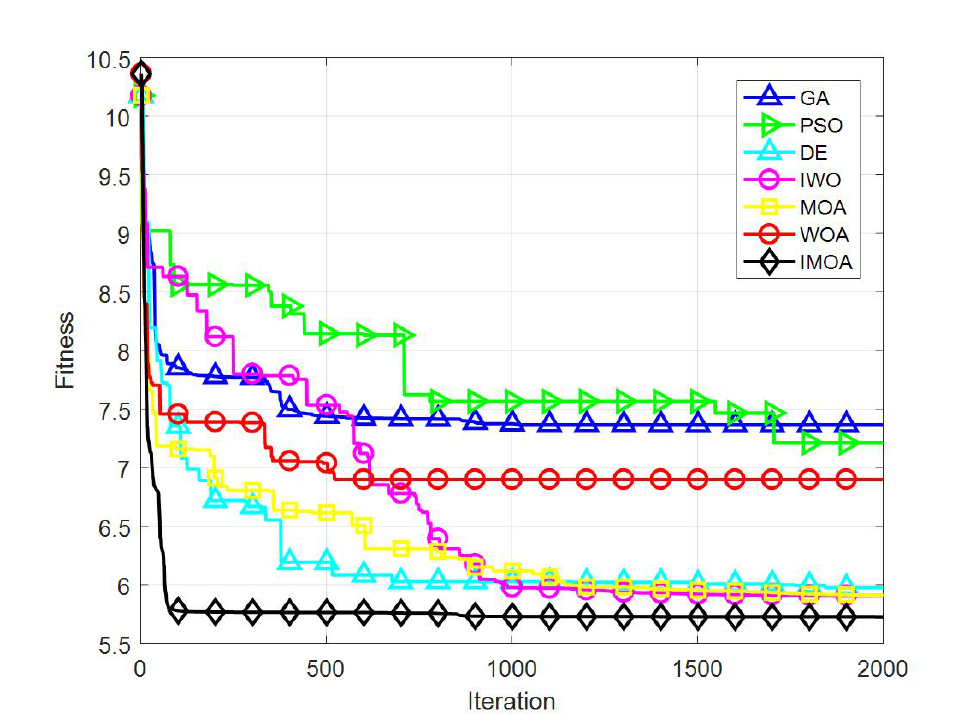
Figure 8. Convergence rates of a 528-element planar phased array.